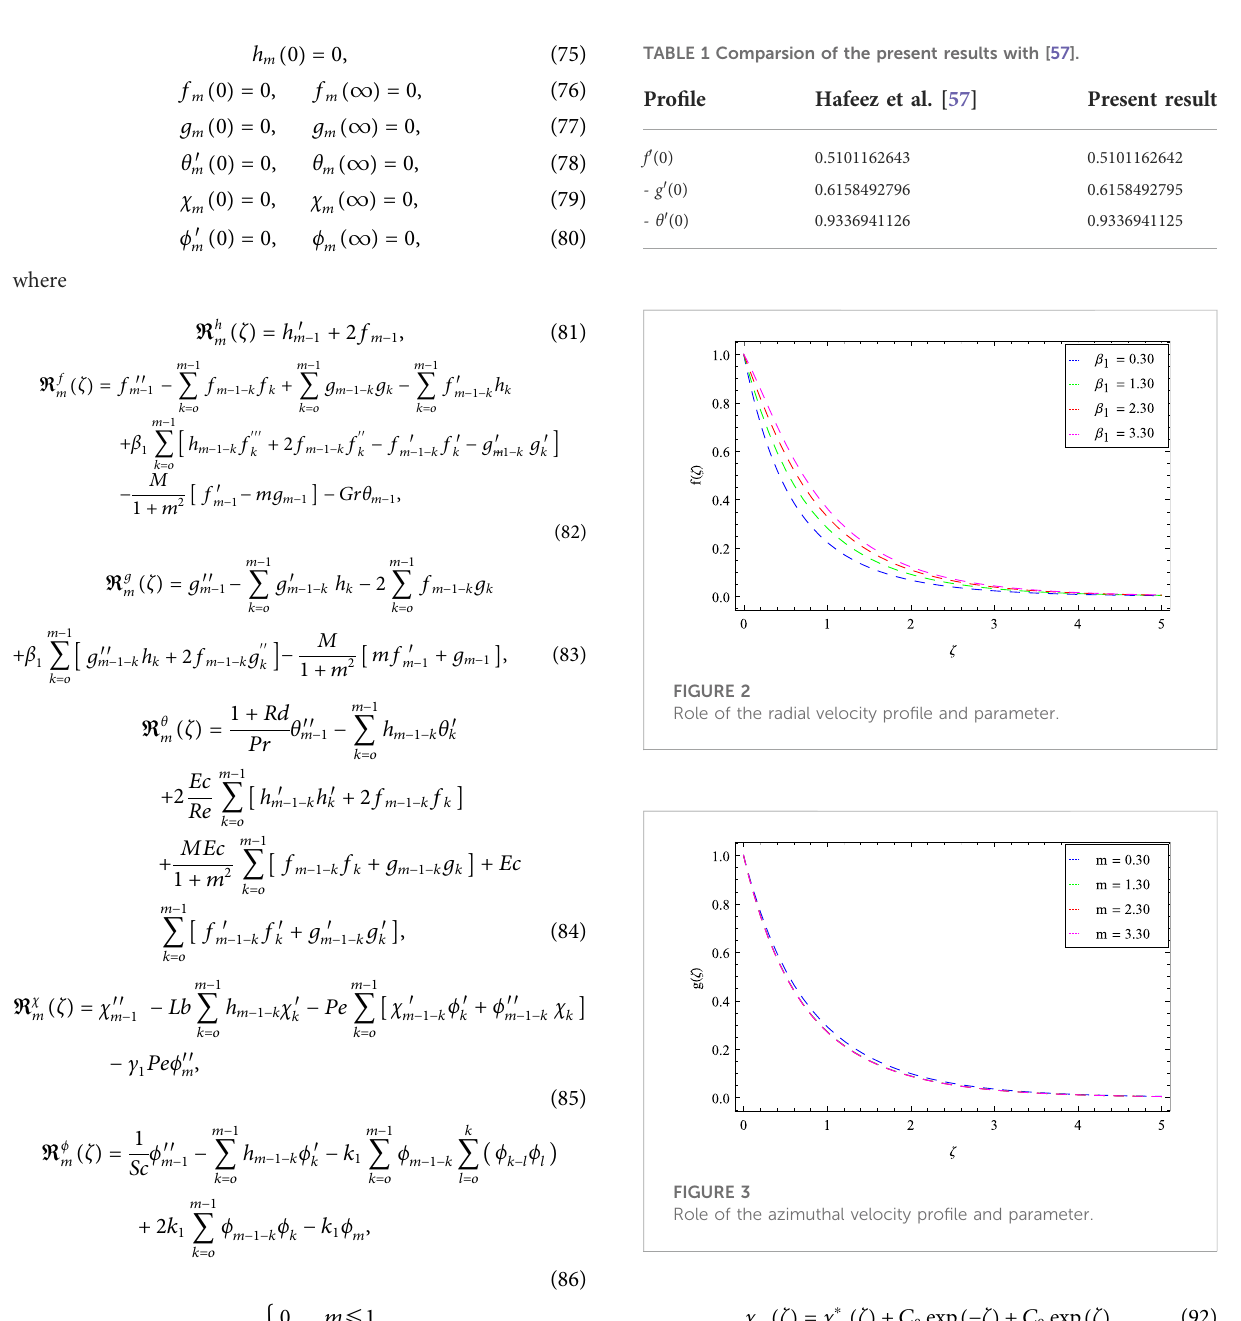
FIGURE 3 Role of the azimuthal velocity pro fi le and